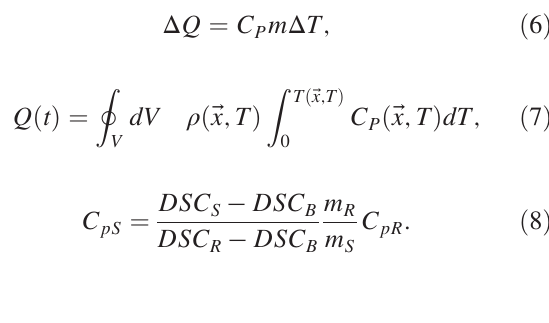
FIG. 10. Relative change in length and CTE against temper- ature with initial thermal reference of 49 °C ( H ) and 50 . 095 °C ( C ) for CuCD.